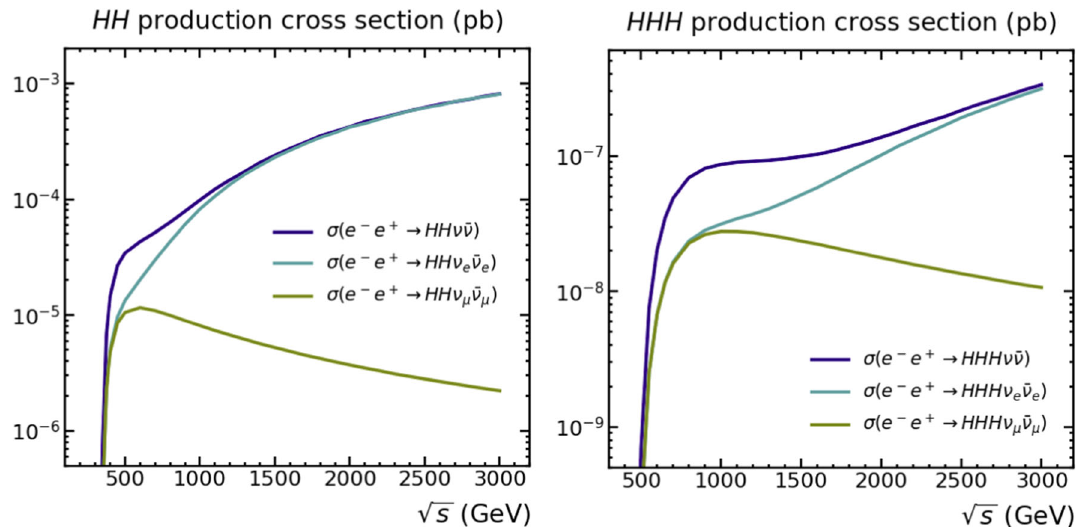
Fig. 3 Predictions for σ( e + e − → H H ν e ¯ ν e ) and σ( e + e − → H H ν μ ¯ ν μ ) (left) and σ( e + e − → H H H ν e ¯ ν e ) and σ( e + e − → H H H ν μ ¯ ν μ ) (right) √ s . The cross sections for e + e − → H H ν ¯ ν and e + e − → H H H ν ¯ ν from the previous figure are also in the SM as a function of the CM energy shown for comparison